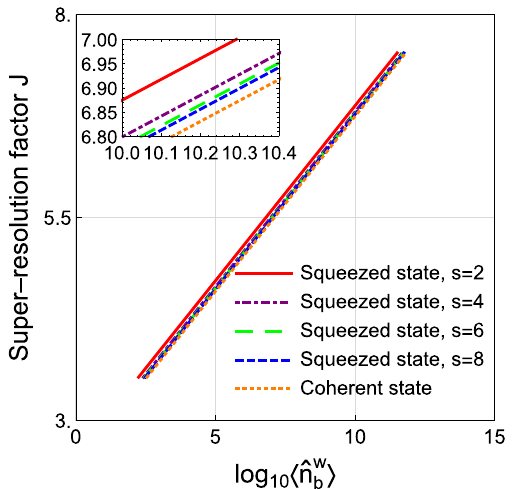
Figure 5. Super-resolution factor J as a function of the mean number of photon in the object plane. The red-solid, green-dashed, blue-dashed, orange-dotted curves denote the squeezed state ( s 4 ), squeezed state ( s 6 ), squeezed state ( s 8 ), and coherent state, respectively. Parameters: g ( s = = =